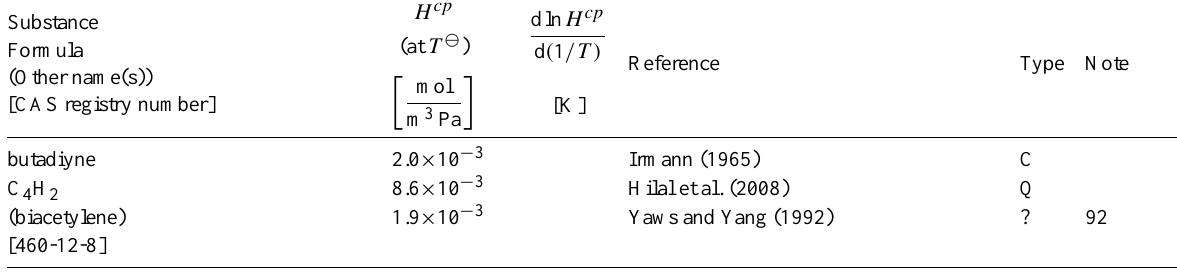
Table 6: Henry’s law constants for water as solvent